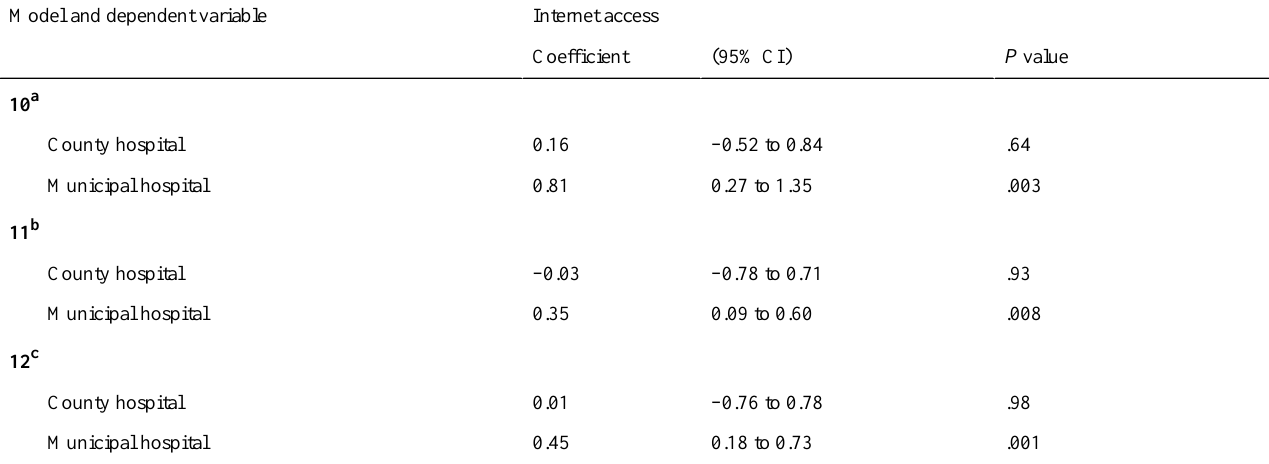
Internet accessModel and dependent